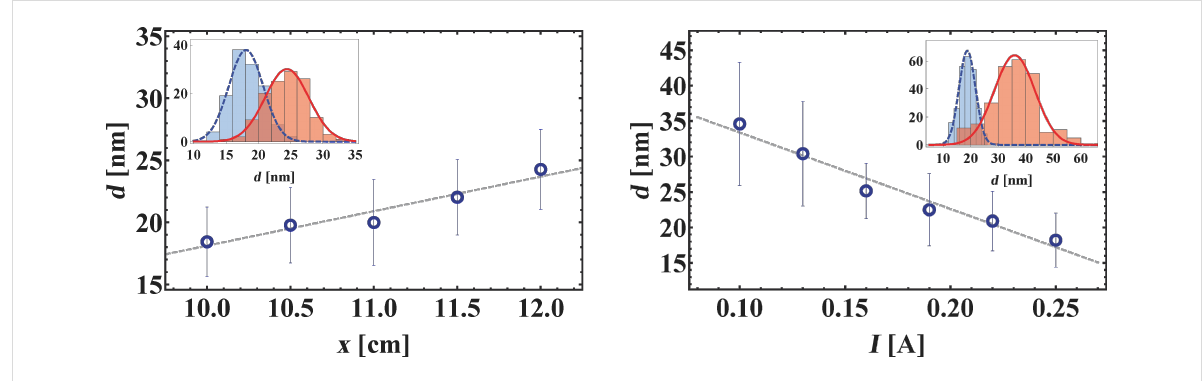
Figure 3: Elemental Ni NP diameter dependency on a) aggregation length L 1 and b) electrical current of the sputter gun SG 1 . Several hundred parti- cles imaged with SEM have been analyzed by hand to gain satisfactory statistics. Interestingly, particle distributions are close to Gaussian and show little resemblance with log-normal size distributions that have been predicted theoretically.